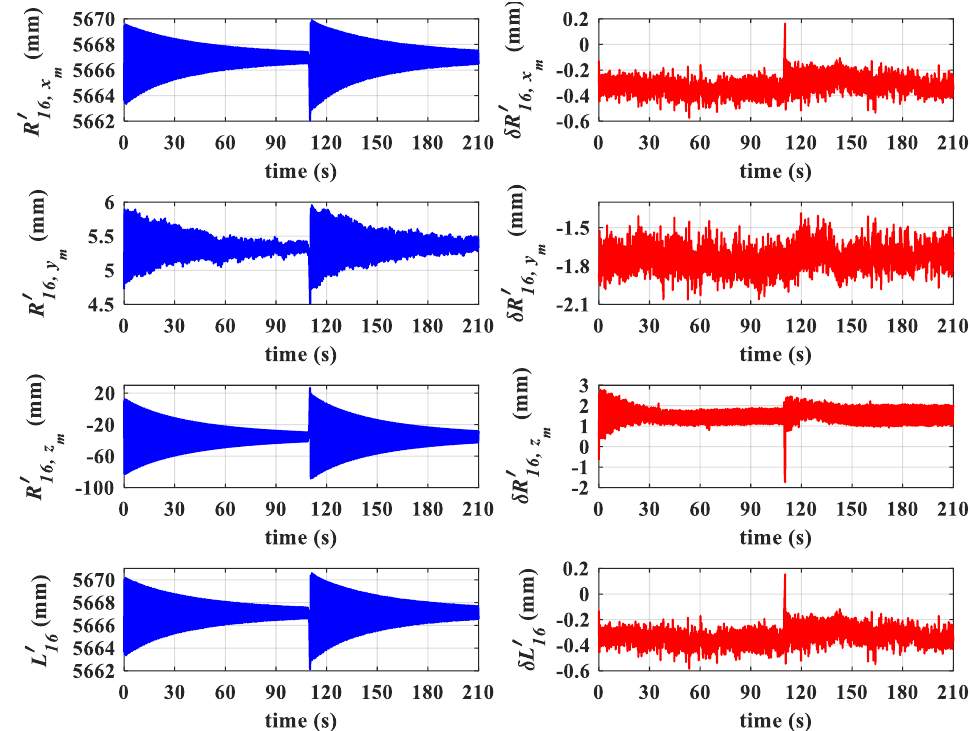
Figure 14. Measured values and errors of relative position and baseline length between antennas 1 and 6.